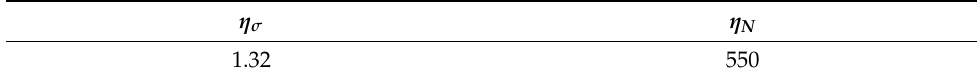
Table 13. Safety factors of composite cylinders.